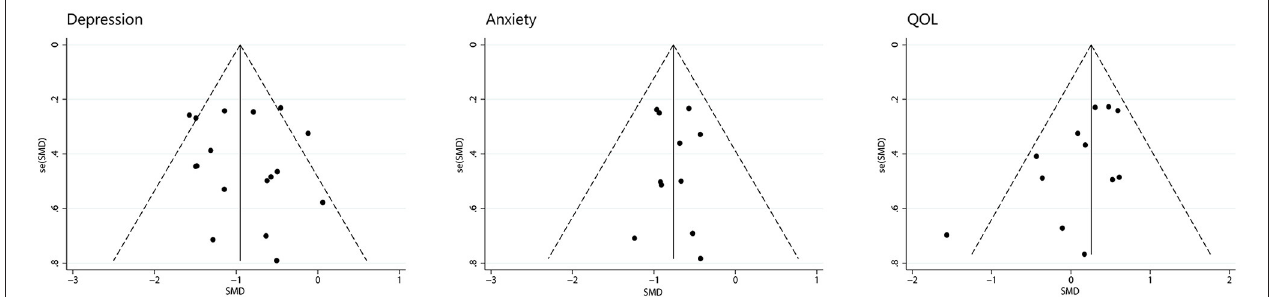
FIGURE 9 | Funnel plot for publication bias